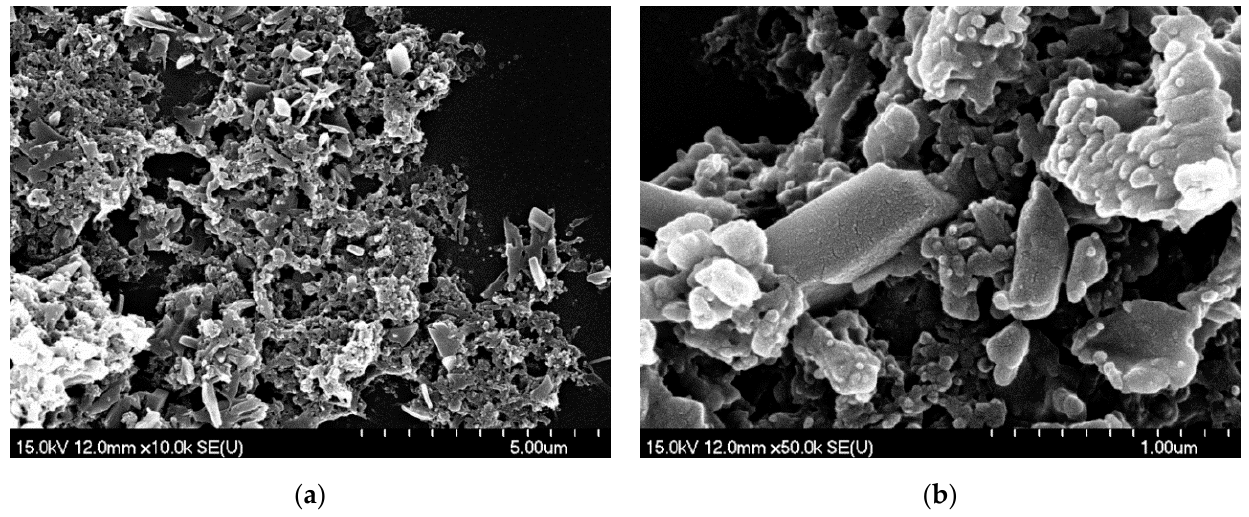
Figure 7. SEM pictures of PLAL-generated particles (at 1.5 J/cm 2 fluence) dried on a silicon plate: crystal-like particles as well as near-amorphous particles and a shapeless mass of conglomerated material. ( a ) M: 10k; ( b ) M: 50k.